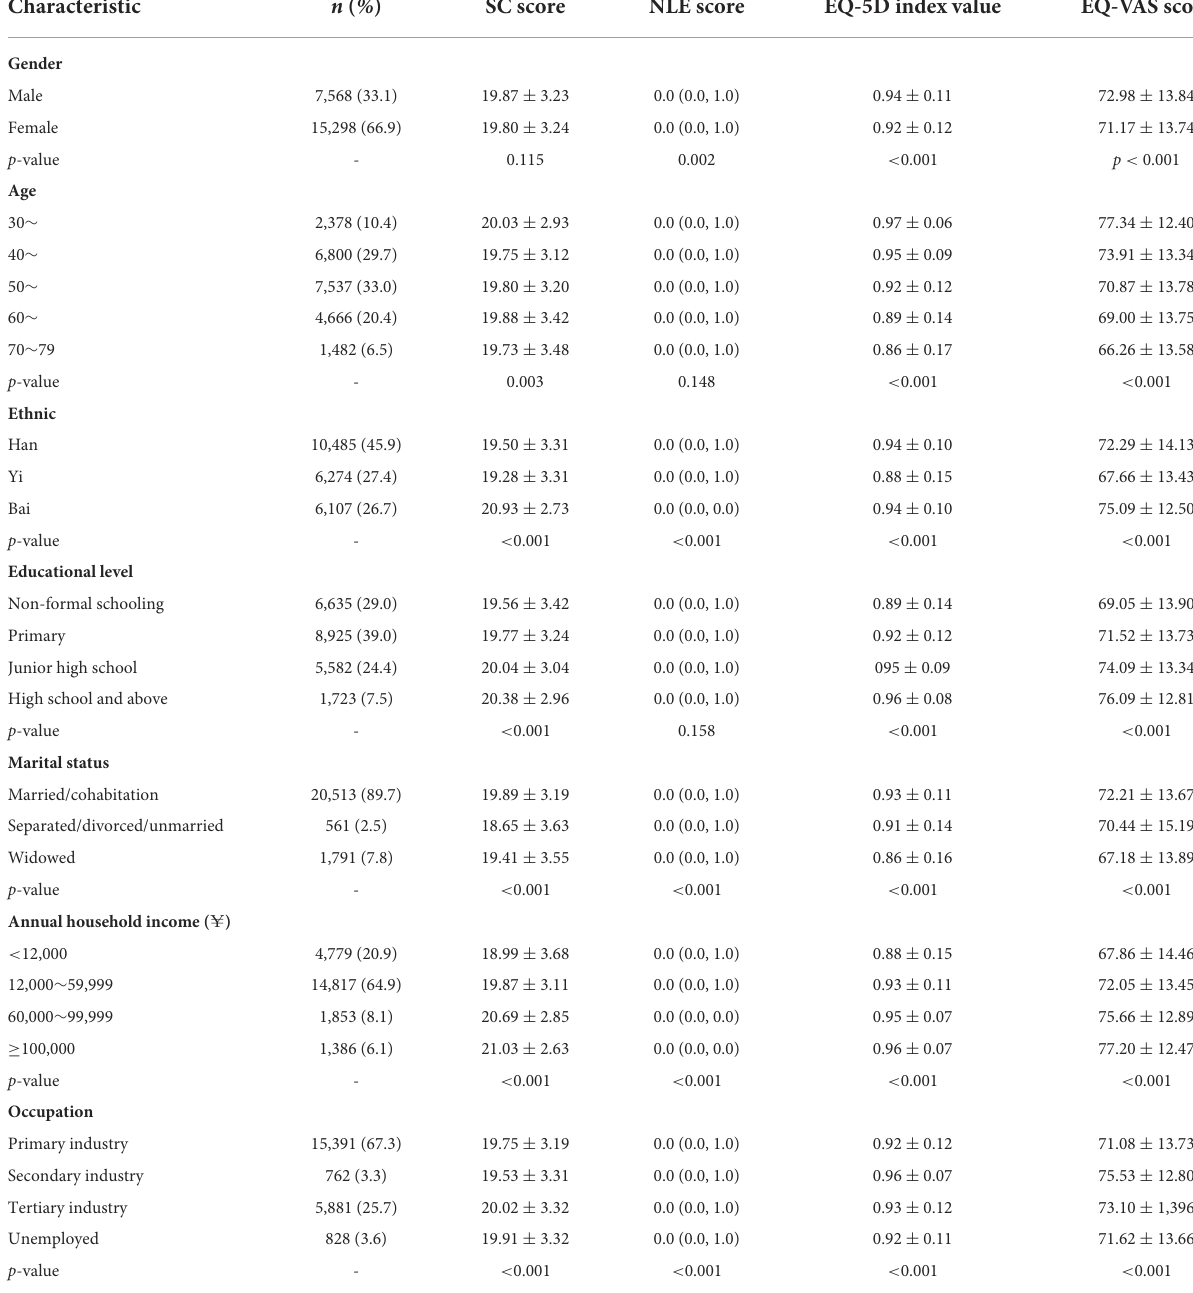
TABLE 1 The comparison of the key measurement variables in different sample